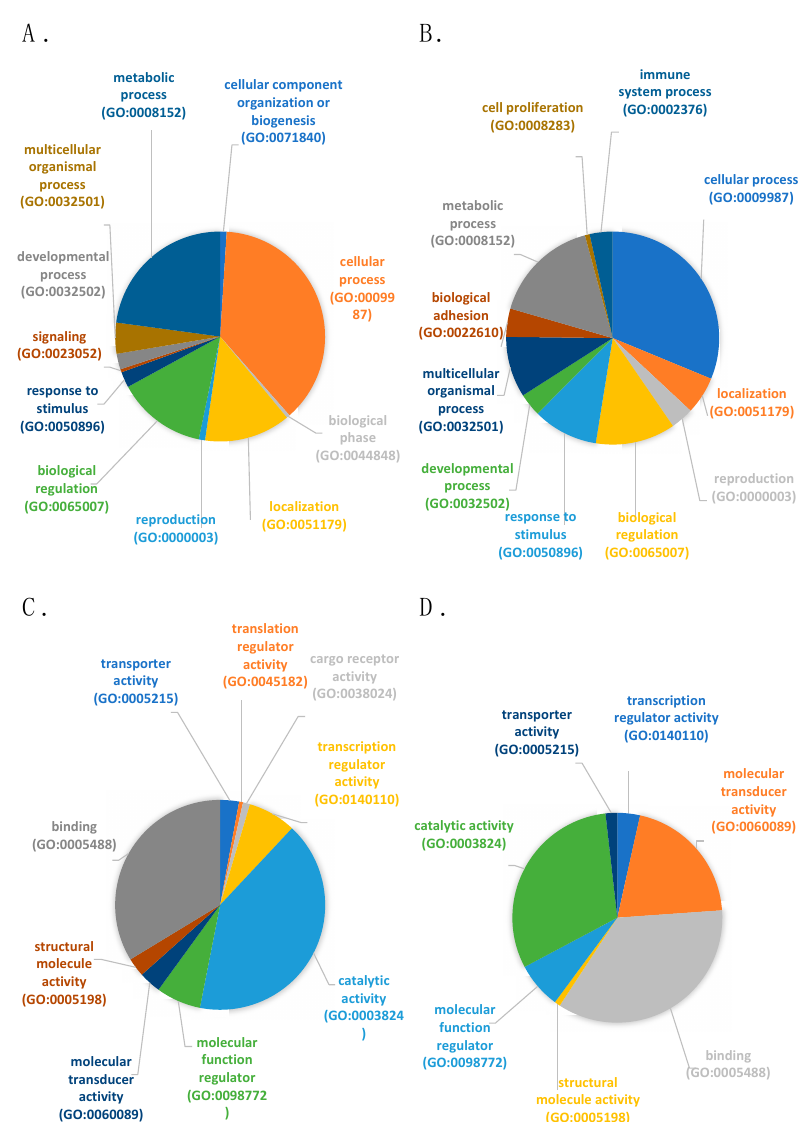
Figure 2. Di ff erentially expressed genes (DEGs) classification (PANTHER) according to 1) biological process ( A ). up-regulated genes in high-fertile boars and ( B ). down-regulated genes in high-fertile boars; and 2) molecular function ( C ). up-regulated genes in high-fertile boars and ( D ). down-regulated genes in high-fertile boars.